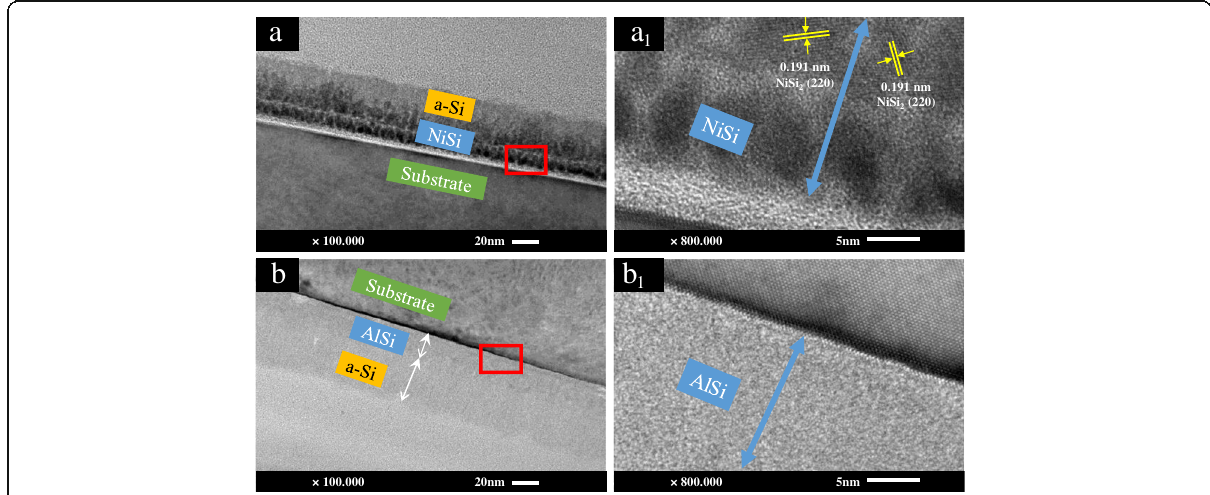
Fig. 5 The cross-sectional TEM images of a NiSi/Si (NS-1) and b AlSi/Si (AS-1) films annealed at 500 °C and high-resolution images of a 1 NiSi/Si (NS-1) and b 1 AlSi/Si (AS-1) films derived from the areas marked with red rectangles in Fig. 5a,